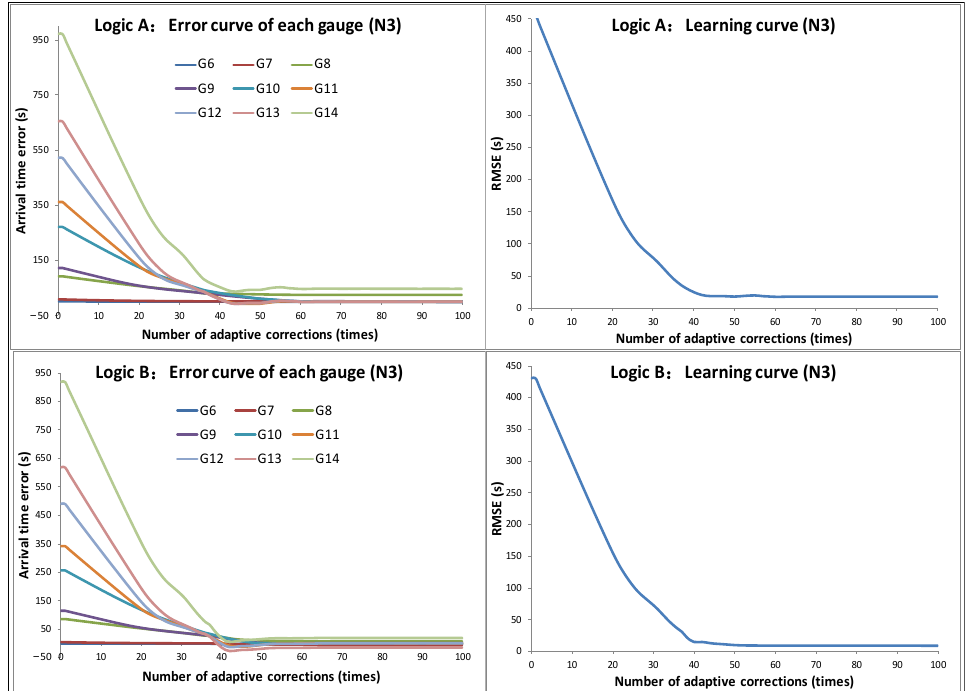
Figure 11. Error curve and learning curve of each gauge in logic-A and logic-B ( N 3 ).